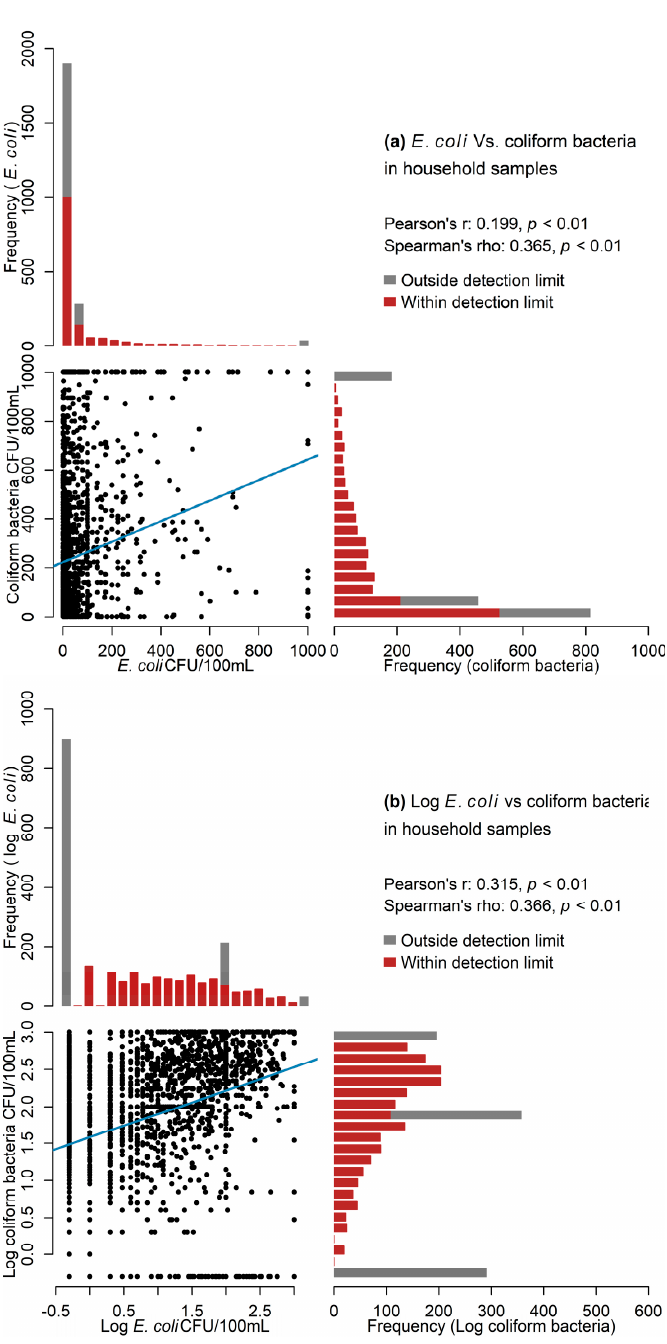
Figure 6. Multipanel plots combining a scatterplot with adjacent histograms to illustrate association between E. coli and other coliform values in household water samples, in Bangladesh: ( a ) without transformation; ( b ) log-transformed data.